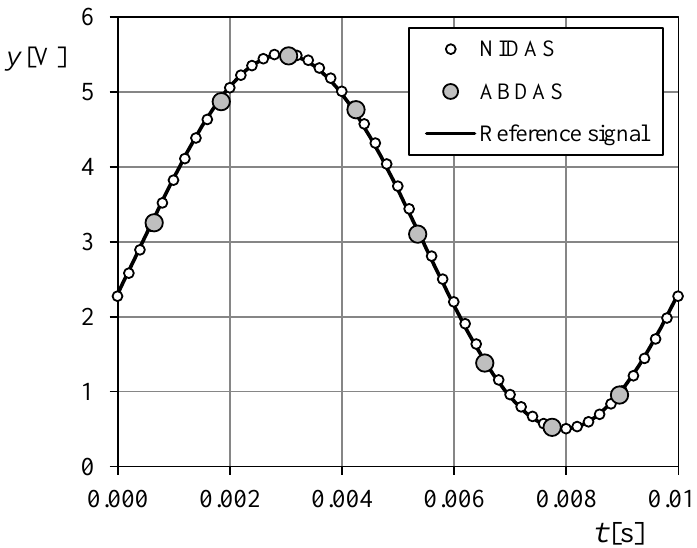
Figure 10. One wave period of the 10 Hz frequency reference signal (Equation (3)). The data measured with NIDAS and ABDAS have been included for comparison purposes.